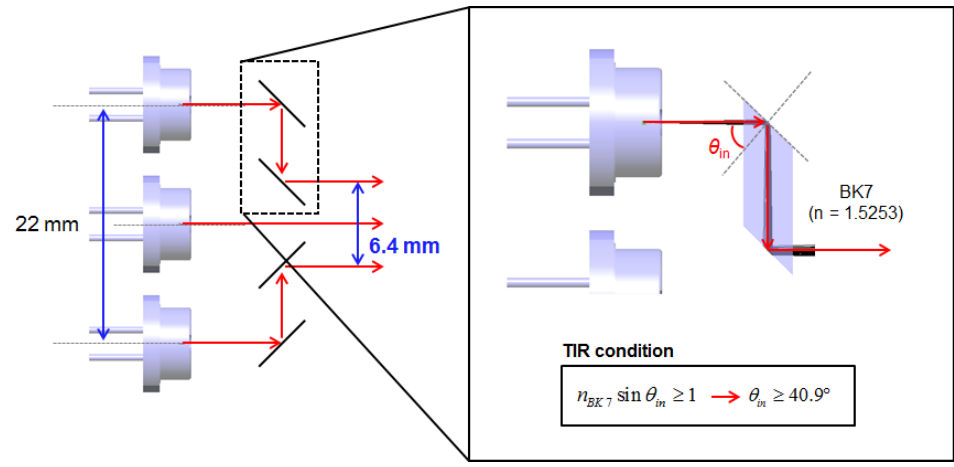
Figure 4. Simplified optical system structure using the total reflection characteristics of a rhombus prism.